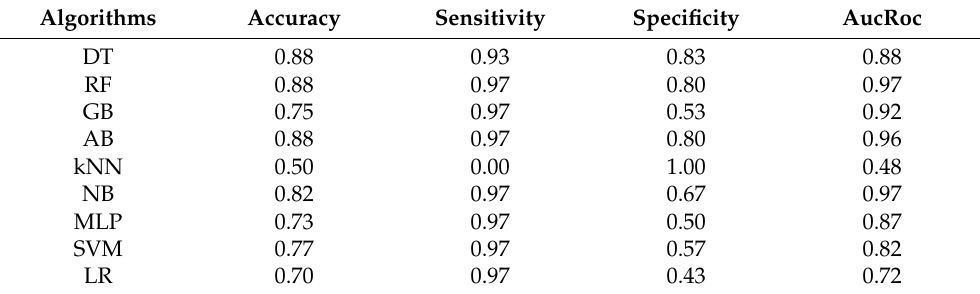
Table 7. Scores from leave-one-subject-out evaluation metrics considering the entire study sample and using the features extracted from both acceleration and angular velocity signals along the three axes. Algorithms Accuracy Sensitivity Specificity AucRoc DT